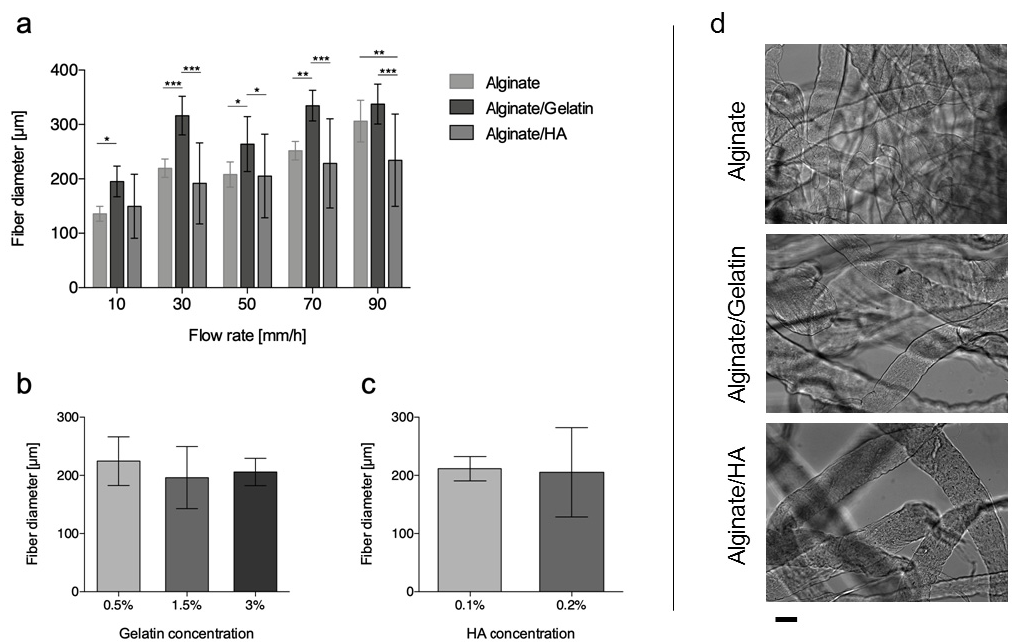
Figure 3. Effects of different parameters on fiber dimensions. ( a ) Effects of solution composition and solution flow rates. Effect of blend components on fiber diameters: for ( b ) gelatin and ( c ) HA blends. ( d ) Optical images of alginate, alginate/gelatin, and alginate/HA microfibers. Scale bar = 200 µ m. (* p < 0.05, ** p < 0.01 and *** p <